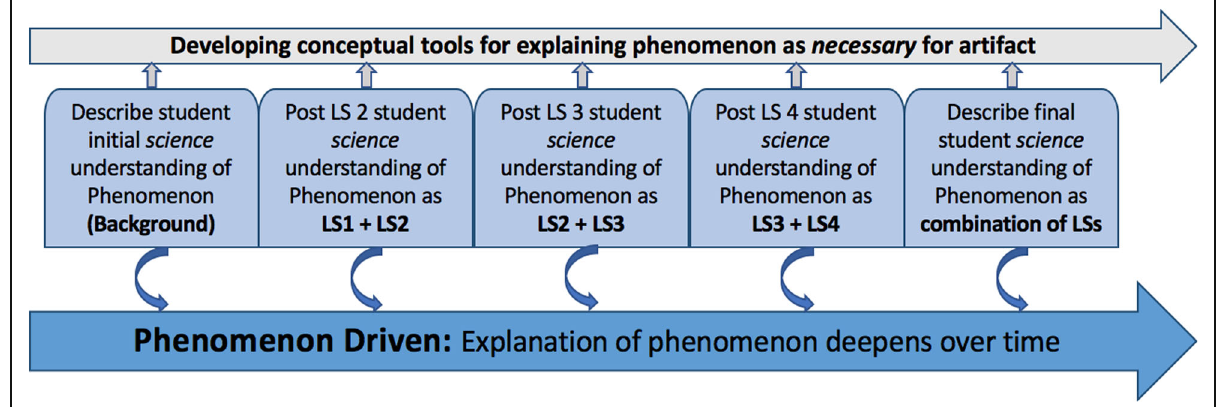
Fig. 1 How application of ideas as conceptual tools is developed and used over time to engage with a phenomenon